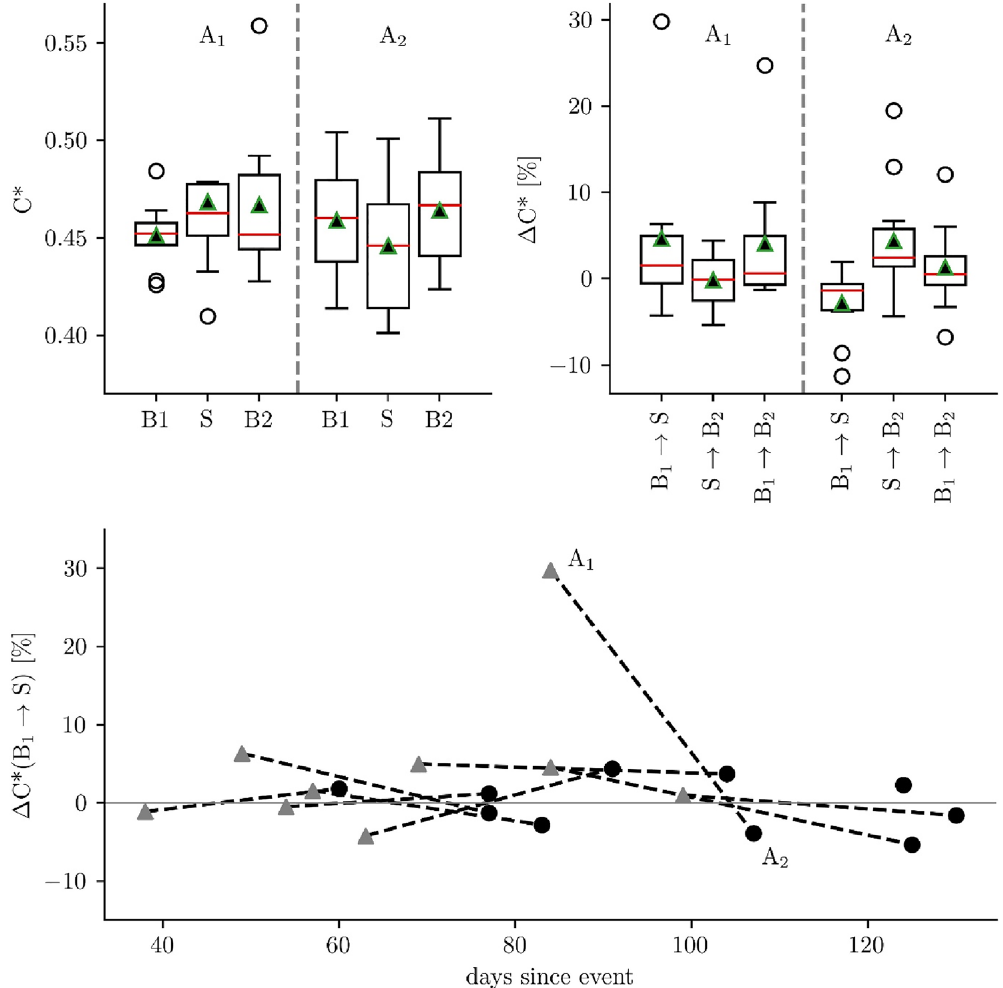
Figure 5. Top: Sample distributions of age-corrected average clustering coefficients C * of evolving functional brain networks during periods B1, S, and B2 (left) as well as of stimulation-induced changes Δ C * between periods (right) at first ( A1 ) and second assessment ( A2 ). Properties of boxplots as in Fig. 2. Bottom: Individual stimulation-induced changes Δ C * between periods B1 and S at first ( A1 : grey triangle) and second assessment ( A2 : black dot) on a time line starting with injury.